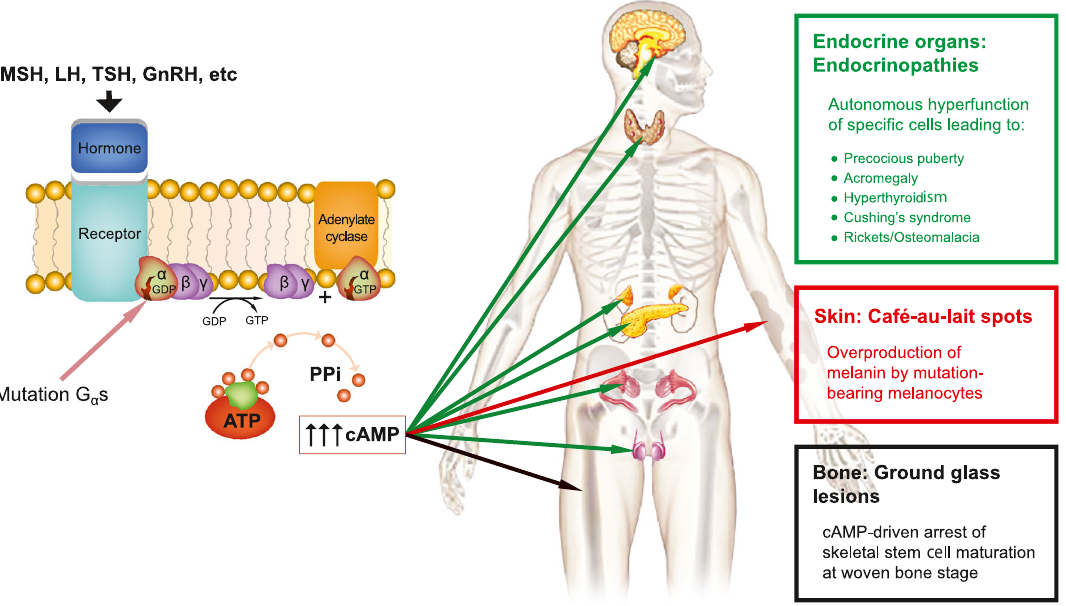
Fig. 1 Post-zygotic mutations of the α -subunit of the Gs stimulatory protein ( GNAS mutations) lead to the inappropriate production of the cyclic adenosine monophosphate (cAMP). In skin, the increased concentration of cAMP results in overproduction of the enzyme